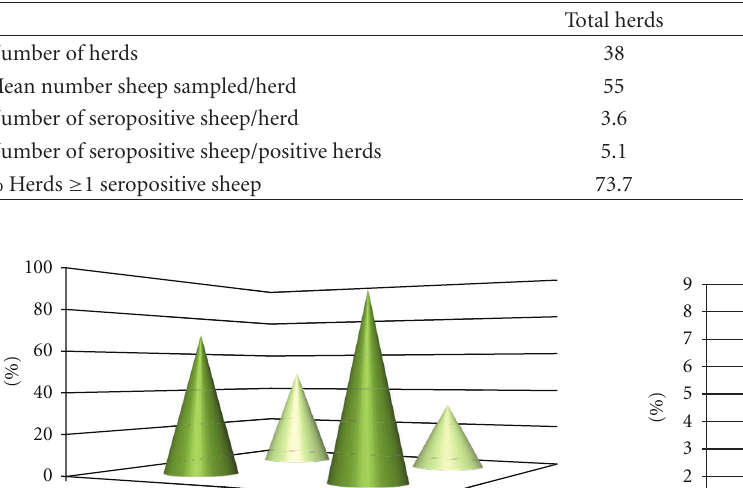
Table 3: Descriptive statistics for dairy and mixed sheep herds.